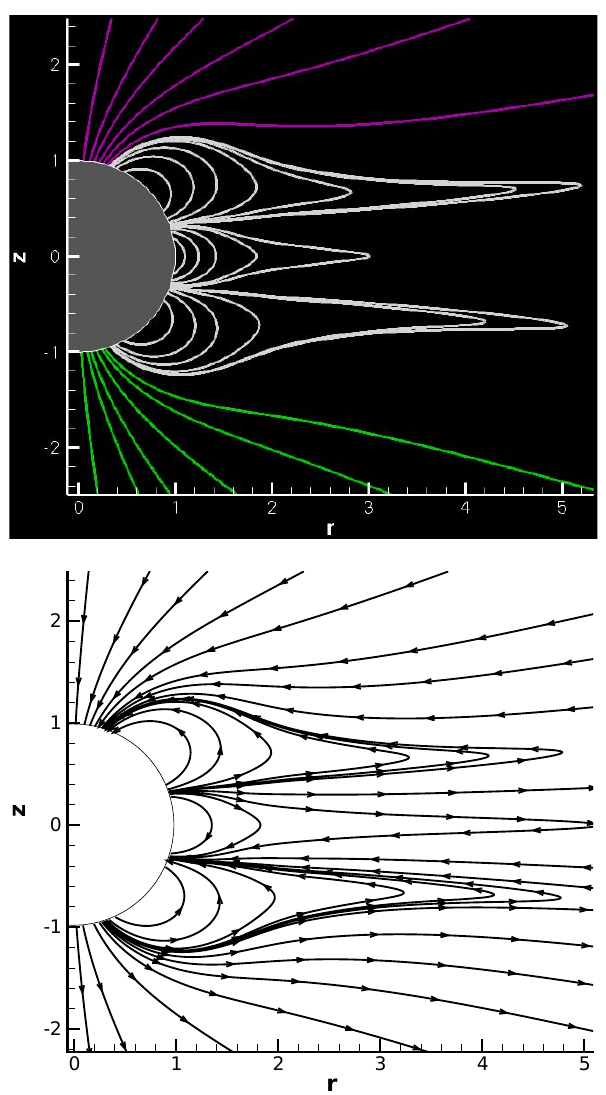
Fig. 3. Top: The initial coronal configuration used in our simu- lations obtained by the potential superpositoin of a dipolar and a quadrupolar configuration. The purple and green colored field lines represent regions of open field lines and fast flow while the three streamers are colored in white. Bottom: The initial coronal config- uration showing the orientation of the magnetic field